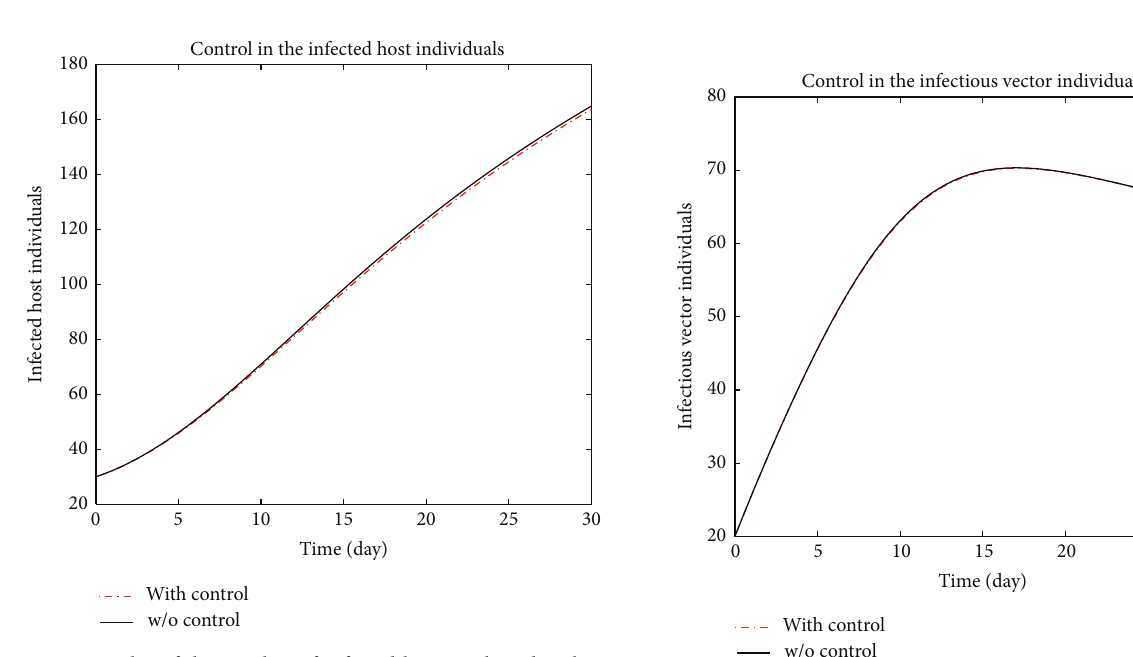
Figure 10: Plot of the number of infected hosts with and without control, 𝑢 1 ̸=0 , 𝑢 2 = 0 .